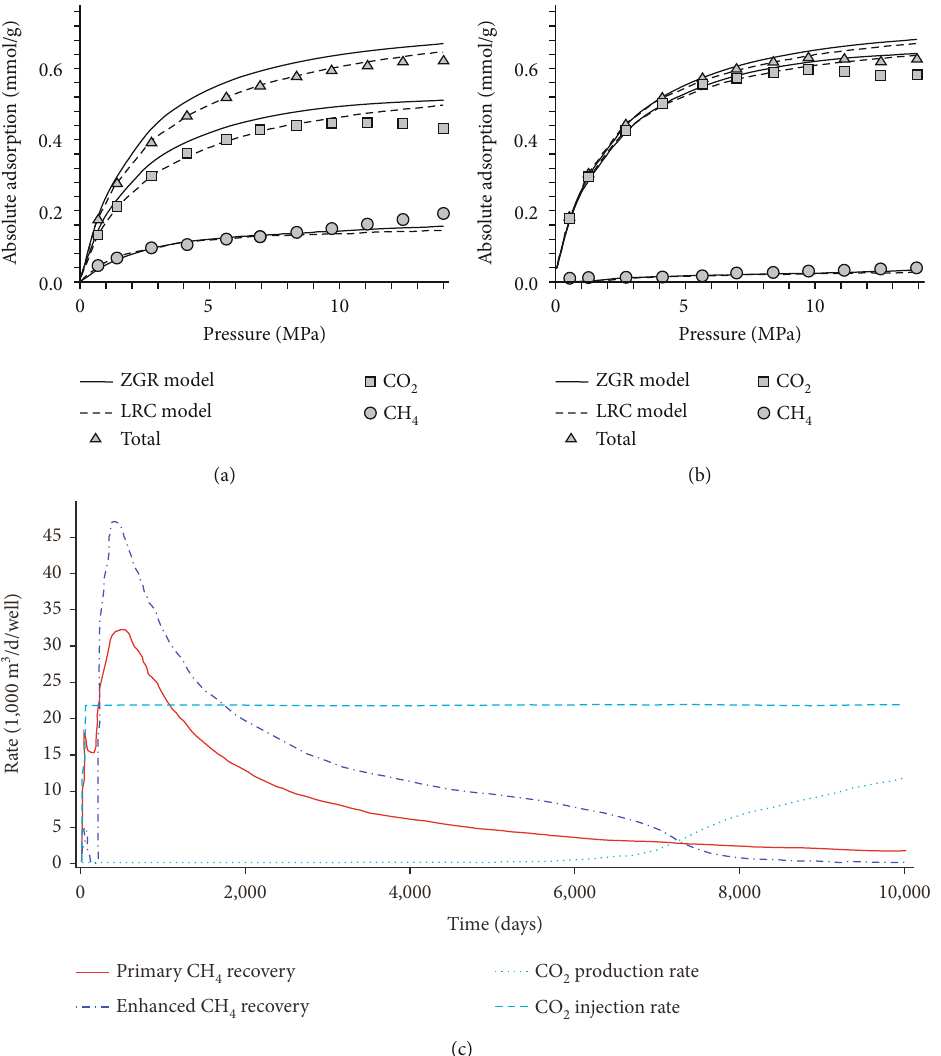
Figure 24: (a) Absolute adsorption of 40/60 mole% mixture: CH Absolute adsorption of 20/80 mole% mixture: N primary gas recovery and the CO